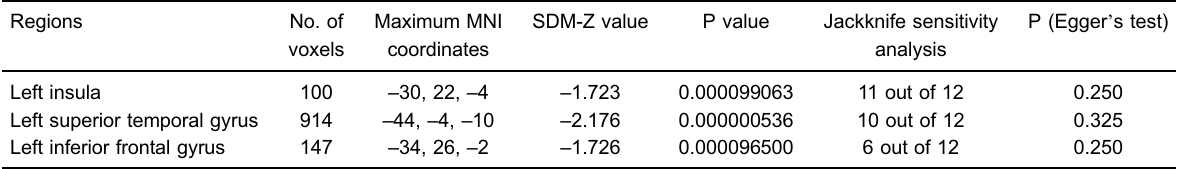
Table 1. Clusters of gray matter volume reductions in patients with Parkinson ’ s disease with mild cognitive impairment compared with Parkinson ’ s disease with normal cognitive function. Regions